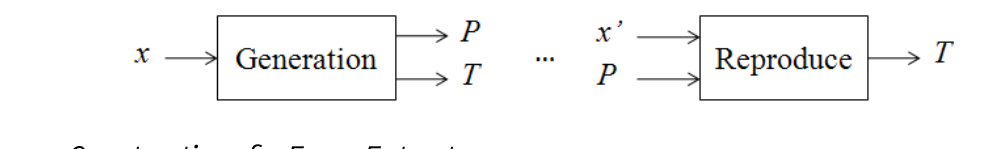
Figure 1. Fuzzy extractor in